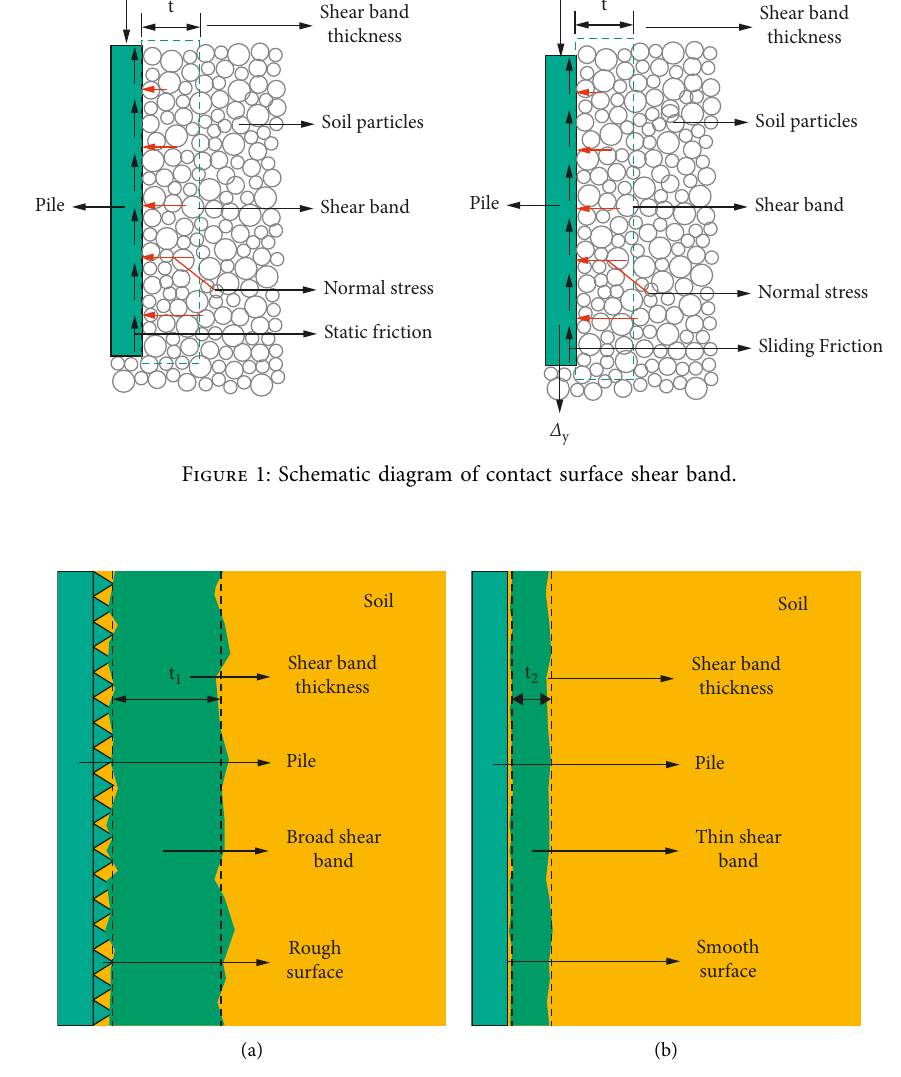
Figure 2: Schematic diagram of contact surface thickness. (a) Broad shear band. (b) Thin shear